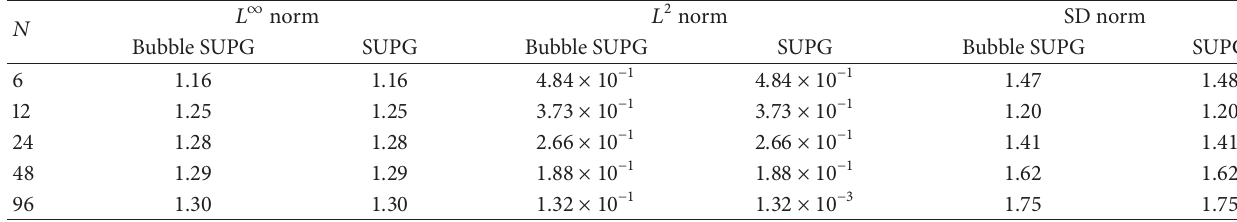
Table 20: 𝜀 = 10 −8 , Problem 4 (comparison of global